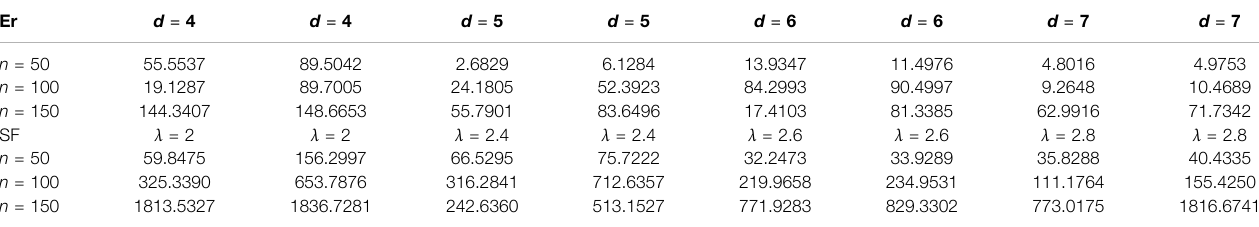
TABLE2| RobustnessimprovementmadebythetwoselectedextremesolutionsfromtheParetofrontforeachofthetestedErd ő s – Rényi(ER)andscale-free(SF)networks.